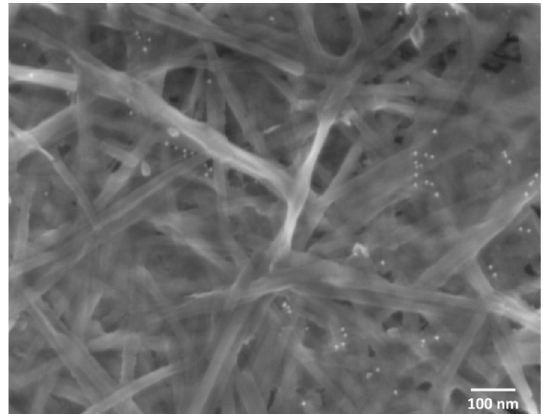
Figure 4. FE-SEM image of the surface of Pt-modified hexaniobate layer-by-layer (LbL) films with 25 bilayers (the bright small spots are Pt nanoclusters). Reproduced with permission from the authors of [36]. Copyright (2019), Elsevier, Amsterdam, Netherlands.